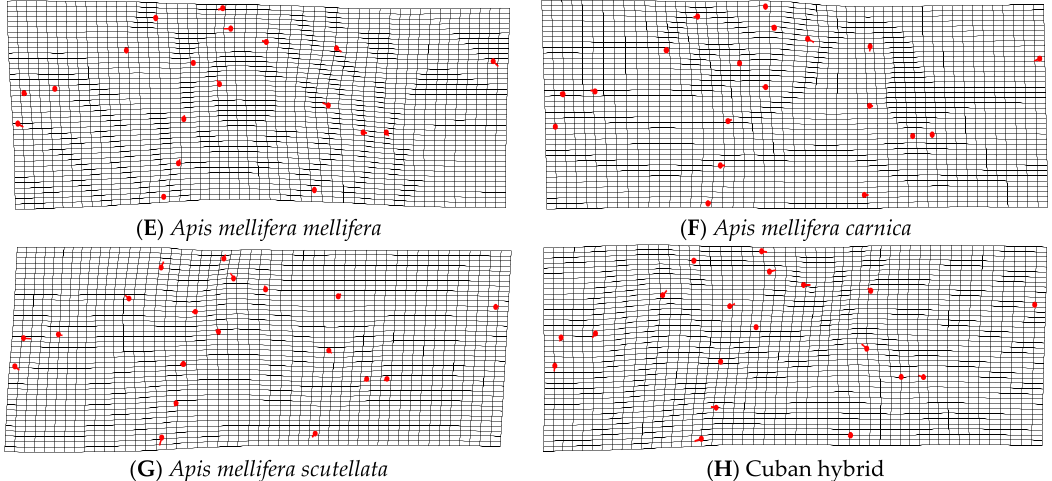
Figure 5. Comparison of deformation grids of bees from the centers for rearing queens with: The Mahalanobis distances were closest for A. m. mellifera (D 2 = 3.77), and showed greater distances concerning the subspecies A. m. scutellata (D 2 = 5.18); A. m. caucasia (D 2 = 6.08); A. m. ligustica (D 2 = 6.27); A. m. carnica (D 2 = 6.62); A. m. iberiensis (D 2 = 4.92); and A. m. intermissa (D 2 = 4.3). The UPGMA analysis resulted in four main clusters, locating a Phenon line at 2.68 (Figure 6). The first includes individuals of the A lineage ( A. m. scutel- lineage ( A. m. ligustica and A. m. carnica ), and the fourth is represented by two sub-groups: